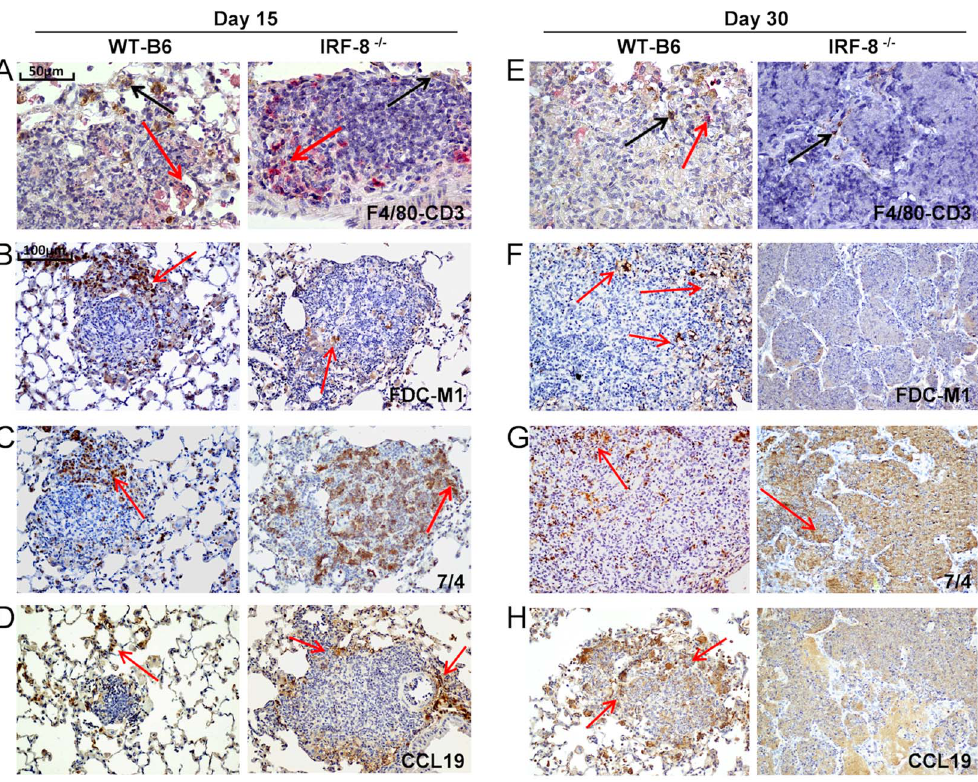
Figure 8. Immune infiltrates into granulomas of Mtb -infected IRF-8 2 / 2 vs. WT-B6 mice. IHC analysis of pulmonary sections from Mtb - infected mice at days 15 and 30 p.i. showing the distribution of immune cells within granulomatous lesions. A, E) Co-staining with anti-F4/80 (brown) and anti-CD3 (red) mAbs, depicted by black and red arrows respectively. B–D, F–H) Staining with the indicated mAbs (brown). Red arrows depict marker-positive cells. Representative slides are shown all taken at 200X magnification, except for A and E taken at 400X magnification. Three independent experiments were performed.